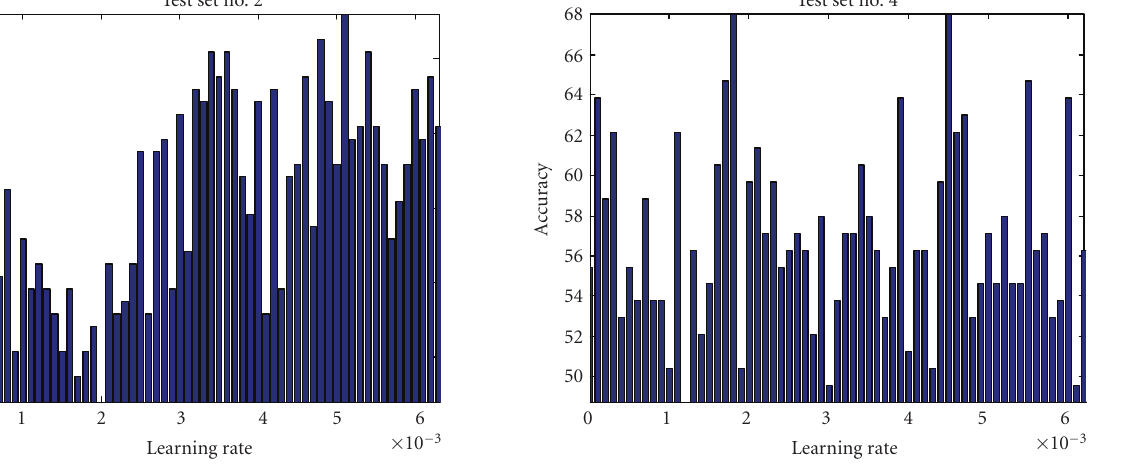
Figure 5: Learning rate impact on algorithm accuracy for test set no. 2 where other parameters are kept constant.